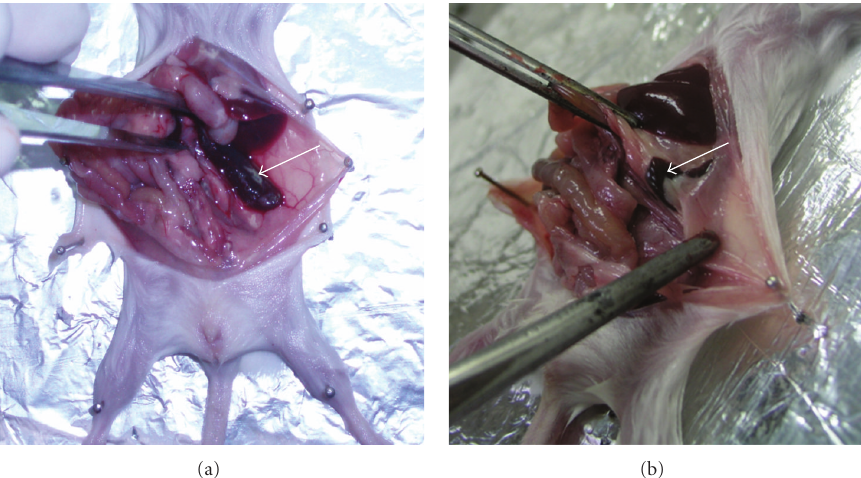
Figure 3: Splenic fibrosis observed after repeated immunizations with recombinant PfP0. (a) Spleen of control mice. (b) Spleen of a mouse following repeated immunization with recombinant PfP0 (four weekly and seven monthly). Arrows point to the spleen. Note the reduced size of the spleen and fibrosis around it. Histopathological analysis revealed a loss of lymphoid cells and extensive replacement of splenic tissue with connective